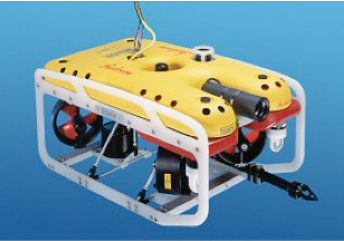
Figure 5: Example of open frame underwater vehicle with x-type thruster configuration. Picture courtesy of Saab Seaeye Ltd,